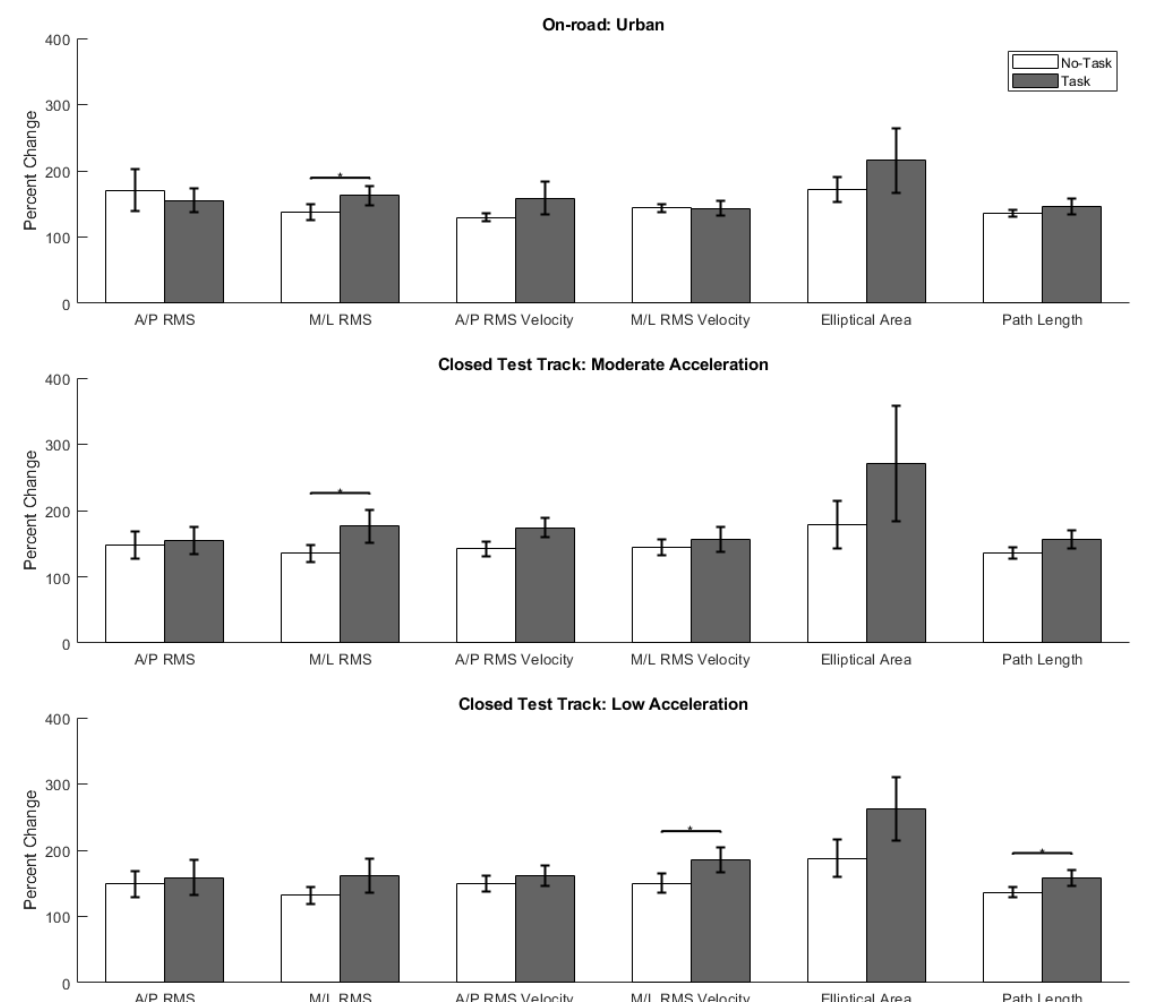
Figure 2. Bar plot illustrating the means and standard errors for the six normalized balance metrics for Exercise 3 (feet together/eyes closed/foam support) across studies. Abbreviations: RMS = root mean square; A/P = anteroposterior; M/L = mediolateral; and EA = Elliptical Area. A/P and M/L RMS are in degrees. A/P and M/L RMS velocity are in degrees per second. Elliptical Area and Path Length are in degrees 2 and degrees, respectively. An asterisk (*) denotes a significant difference for the non-parametric comparisons between the No-Task and Task conditions for that metric.